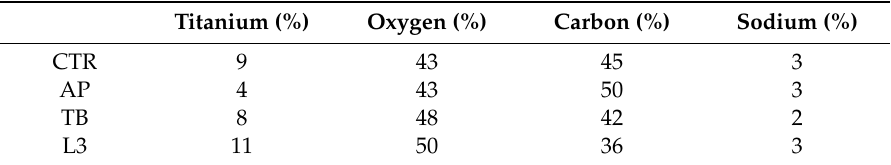
Table 2. Atomic percentage composition of samples.